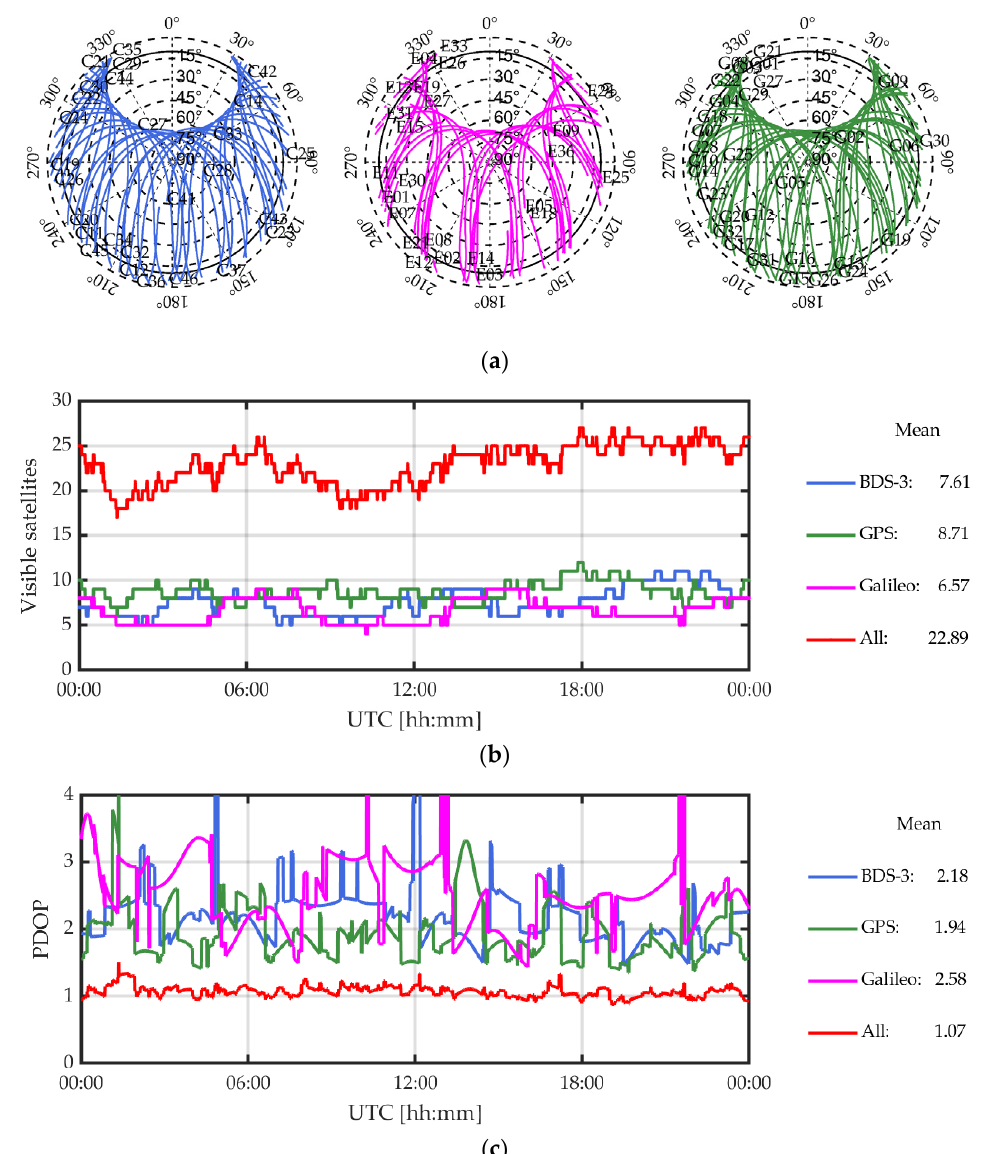
Figure 1. ( a ) Sky plots of BDS-3 (in blue), GPS (in green), and Galileo (in magenta) on day of year (DOY) 120, 2021 at GODN. ( b ) The number of visible satellites of the different global navigation satellite systems (GNSSs) and all the GNSSs (in red). ( c ) The position dilution of precision (PDOP) time-series of different GNSSs and all the GNSSs. In addition, the average number of visible satellites within the day is shown in the legend and all the statistics were computed with a cutoff elevation angle of 10 ◦